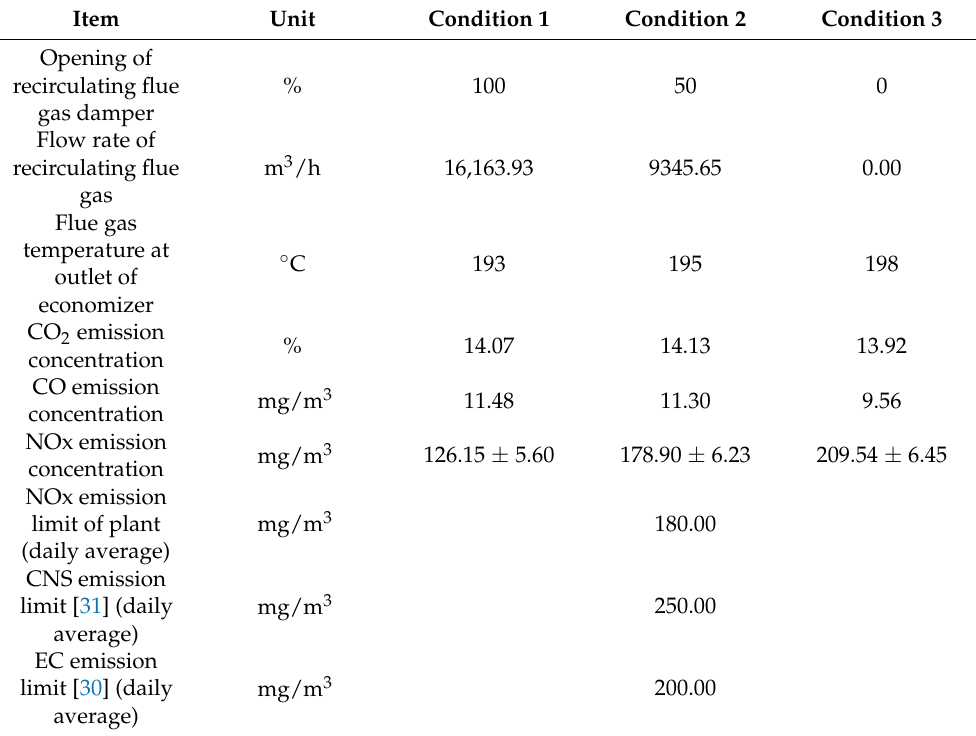
Table 3. The combustion and operation states of the boiler.